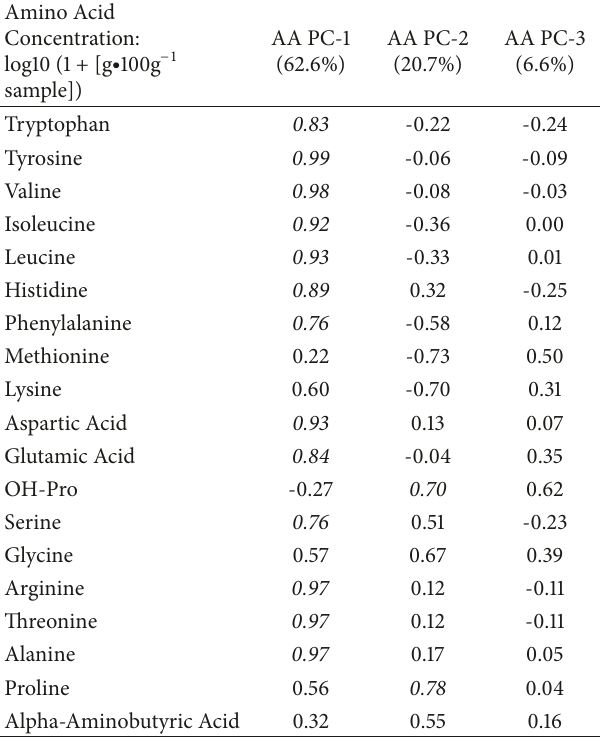
Table 6: Loadings of Amino Acids on Principal Components.